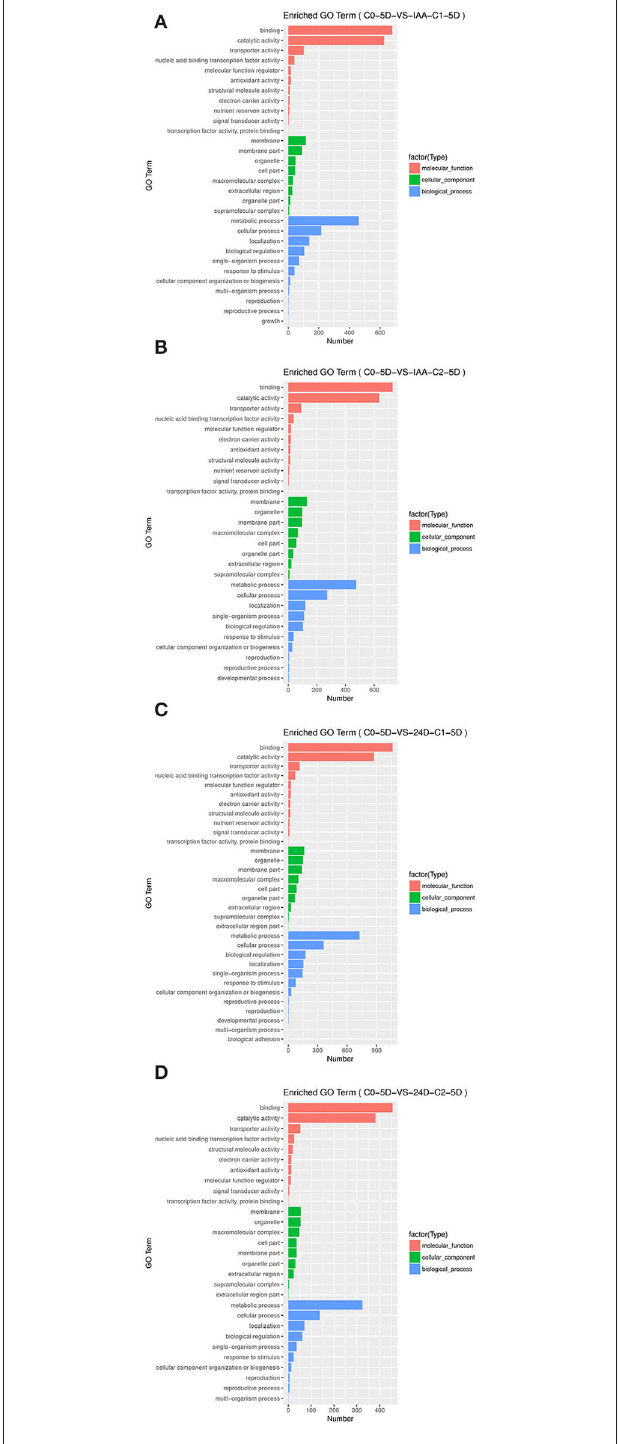
FIGURE 3 | Histogram of GO enrichment of DEGs from samples treated with different auxin concentrations. (A) Enriched GO terms in C0-5D vs. IAA-C1-5D; (B) Enriched GO terms in C0-5D vs. IAA-C2-5D; (C) Enriched GO terms in C0-5D vs. 24D-C1-5D; (D) Enriched GO terms in C0-5D vs. 24D-C2-5D. IAA, indole acetic acid; 24D, 2,4-dichlorophenoxyacetic acid; C0, 0mg L − 1 ; C1, 0.025mg L − 1 ; C2, 0.05mg L − 1 ; 5D, 5 days’